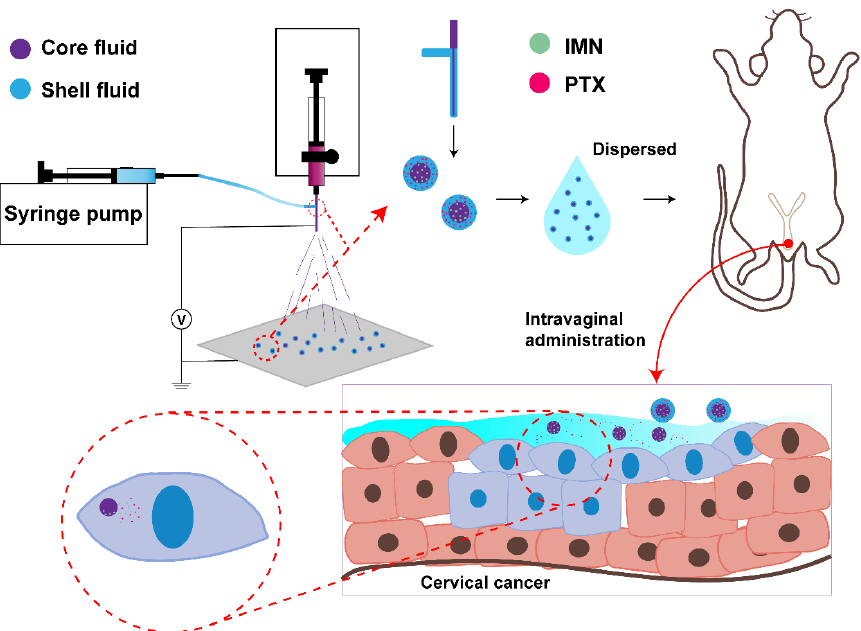
Figure 1. Illustration of the preparation, by coaxial electrospray, of the core–shell microparticle and its action mechanism.